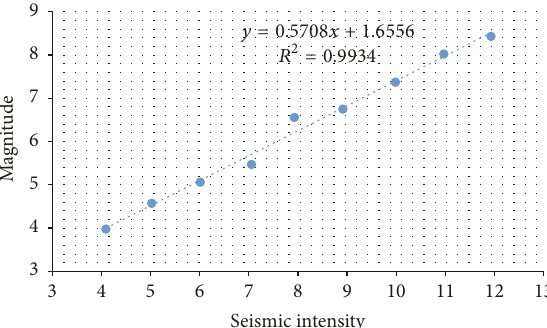
Figure 7: Magnitude versus seismic intensity.